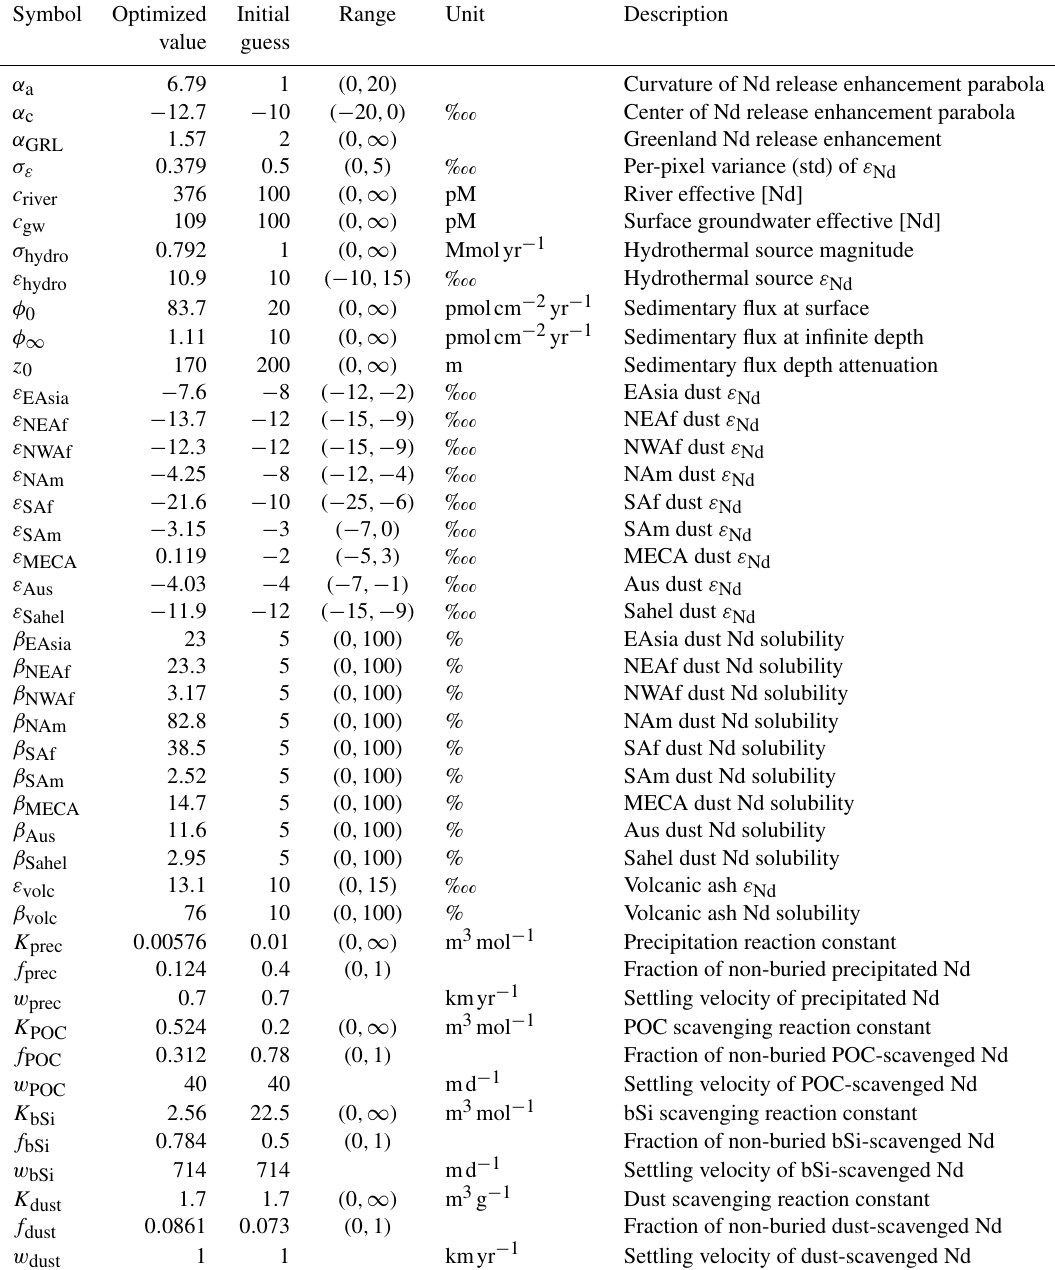
Table 2. List of parameters. Realistic parameter ranges were prescribed based on the literature and the expertise of the authors. Final values have been rounded to three significant digits. Parameters without a range are not optimized (final value equals initial guess). Scavenging reaction constants, K X , are reported in units of inverse concentration of the particle X